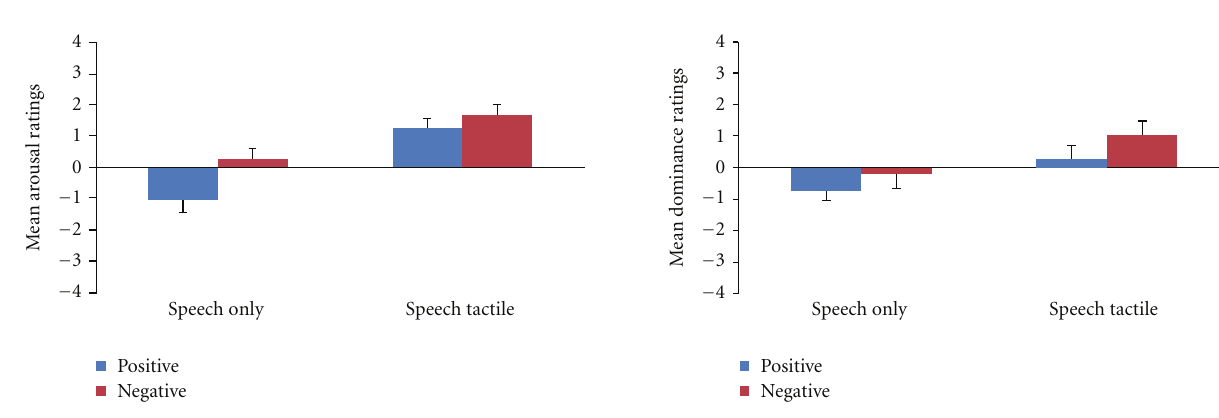
Figure 4: Means and SEMs for the ratings of the stimulus arousal.